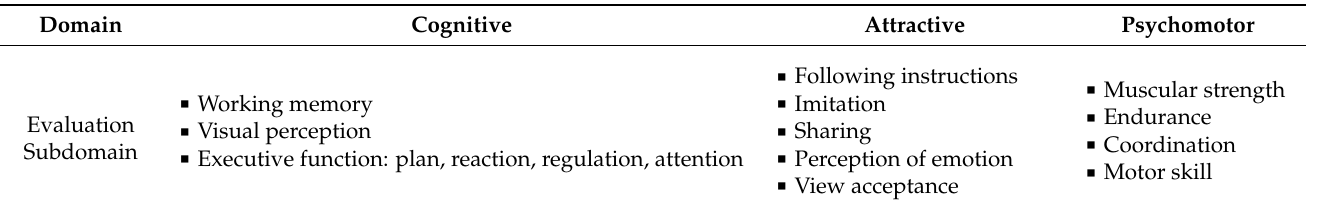
Table 1. Functional evaluation lists in children with Developmental disabilities (DD).